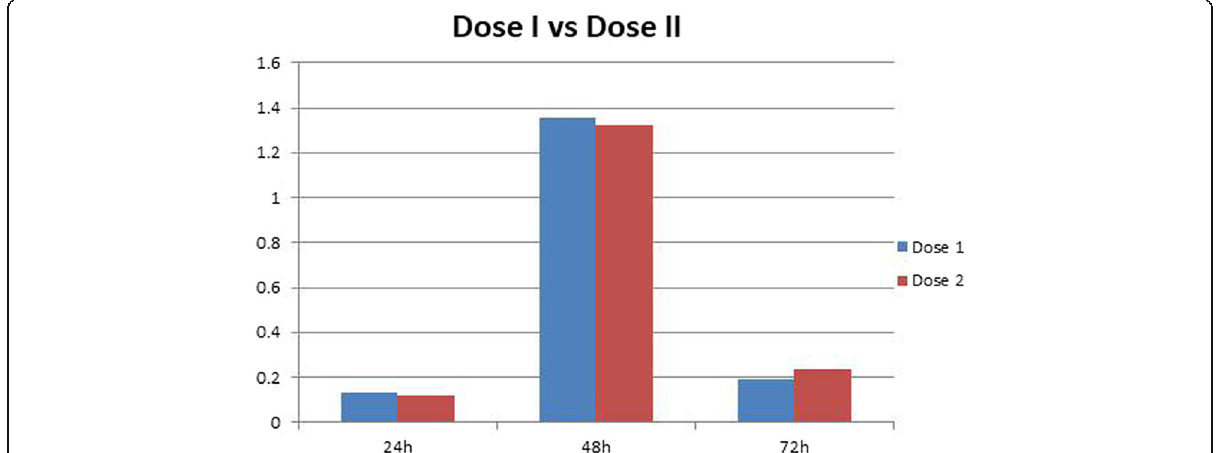
Fig. 5 Histogram illustrating comparison between different